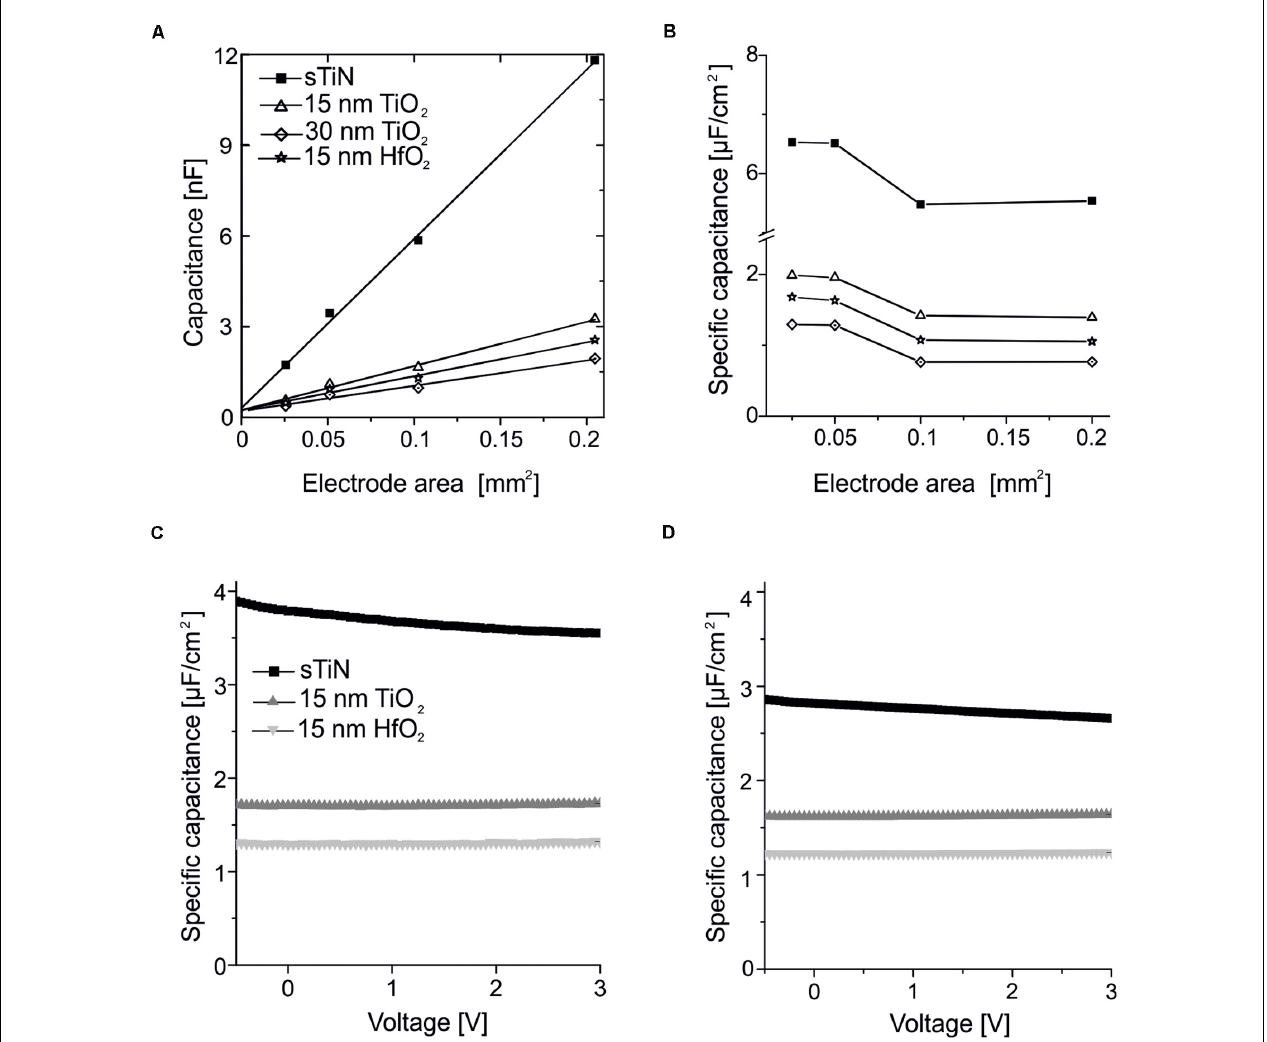
FIGURE 2 | Characterization of the capacitance of the ALD-insulated recording electrodes. (A) Linear dependence of capacitance with electrode area measured using smooth TiN electrodes insulated with 15 or 30 nm of ALD-TiO 2 , or electrodes insulated with 15 nm ALD-HfO 2 . The data are compared to uncoated smooth TiN electrodes. Measurements were performed at a frequency of 1 kHz. The linear fit has a small offset (0.2 nF). (B) Specific capacity over area for smooth TiN with 15 or 30 nm of ALD-TiO 2 , as well as 15 nm ALD-HfO 2 compared to the uncoated smooth TiN electrode at a frequency of 1 kHz. (C) Stable behavior of specific capacitance irrespective of the applied DC voltage applied to the electrode. Measurements were performed at 25-Hz stimulation frequency for 15 nm HfO 2 (light gray), TiO 2 (dark gray) on smooth TiN compared to uncoated TiN electrodes (black line) on large electrodes (320 × 320 µ m 2 ). (D) Same analysis as in panel (C) except that here a test frequency of 1 kHz was